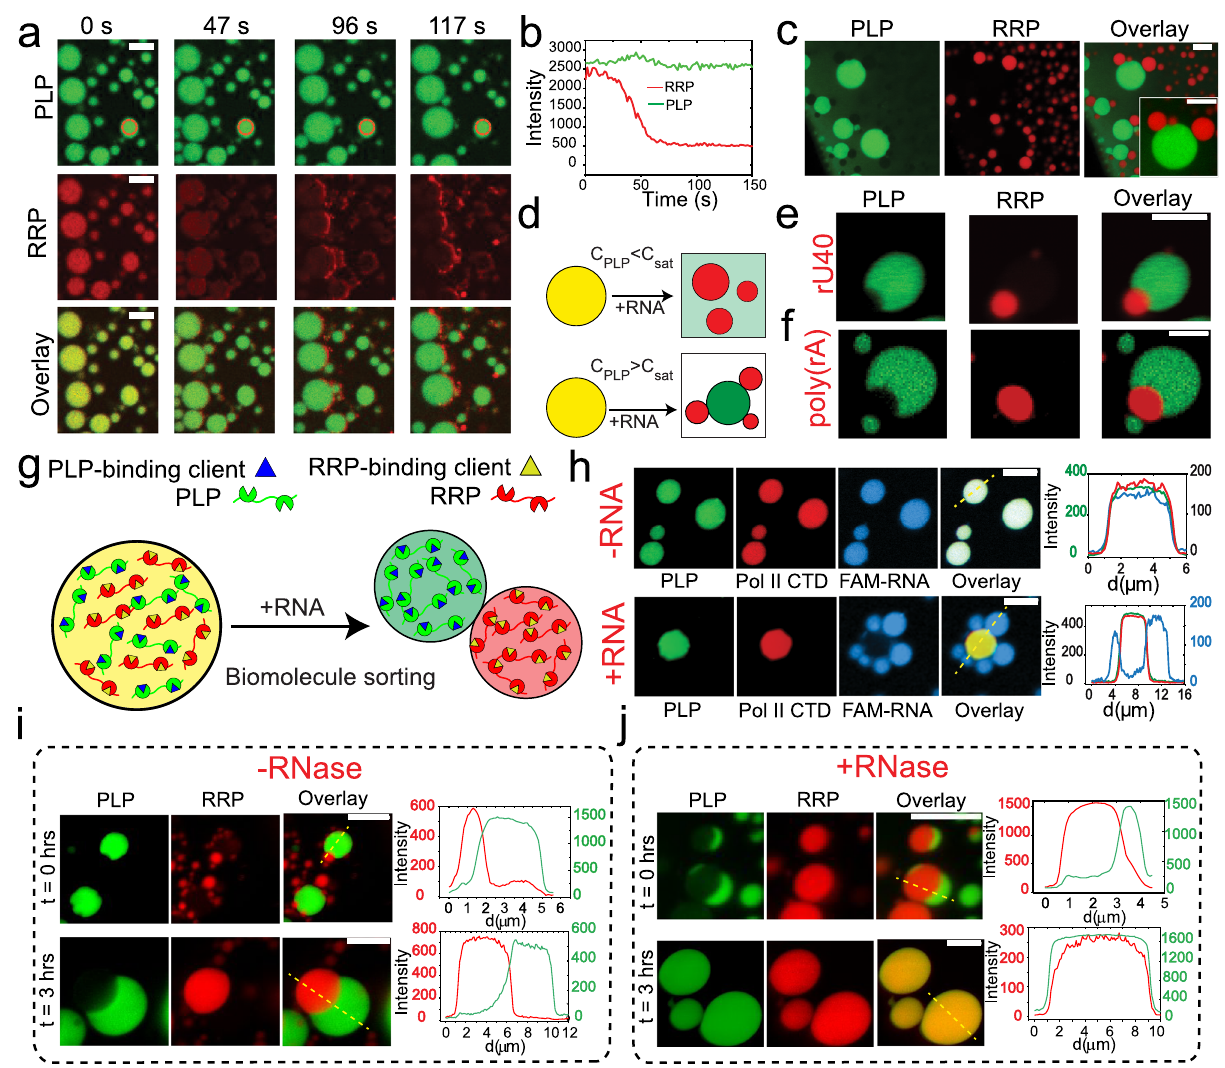
Fig. 3 RNA causes the demixing of RRP and PLP. a Fluorescence time-lapse images showing the sequestration of RRP (FUS RGG3 ) from PLP-RRP droplets and the formation of RRP-RNA droplets upon addition of poly(rU) RNA. [PLP] = 250 µ M; [FUS RGG3 ] = 750 µ M or 2.6mg/ml; and poly(rU) RNA is added to a fi nal concentration of 13mg/ml. b PLP and RRP intensities as a function of time within a PLP-RRP condensate [red circle in ( a )]. c Fluorescence images of coexisting PLP droplets and RRP-RNA droplets 20min after RNA addition. [PLP] = 250 µ M; [FUS RGG3 ] = 1250 µ M (4.3mg/ml); and poly(rU) RNA is added to a fi nal concentration of 10.8mg/ml. d A schematic diagram summarizing the effect of RNA on PLP-RRP condensates. e Fluorescence microscopy images of coexisting PLP condensates (green) and RRP-RNA condensates (red), prepared using rU40 RNA. Each type of droplet was prepared independently at initial concentrations of [PLP] = 400 µ M, [FUS RGG3 ] = 4.0mg/ml and [rU40] = 4.0mg/ml and then mixed (1:1 vol/vol). f Fluorescence images of the coexisting PLP condensates (green) and RRP-RNA condensates (red) prepared using poly(rA) RNA. g A schematic showing that RNA-induced de-mixing of PLP-RRP condensate (yellow) into PLP (green) and RRP-RNA (red) condensates can sort diverse clients into different condensates. h Fluorescence micrographs and intensity pro fi les showing recruitment of a FAM-labeled short ssRNA and Alexa488-labeled Pol II CTD into PLP-RRP condensates in the absence of RNA (top). These RNA and polypeptide molecules are differentially sorted when poly(rU) RNA is added to the mixture (bottom) − FAM-RNA (blue) into RRP-RNA condensates and Pol II CTD (red) into PLP condensates. PLP condensates (PLP = 400 µ M) were mixed (1:1 by volume) with a sample containing 4.0mg/ml [RGRGG] 5 and 0.0mg/ml (top) or 8.0 mg/ml (bottom) of poly(rU) RNA. i , j Fluorescence time-lapse images and intensity pro fi les (across the yellow dashed line) for coexisting PLP droplets and RRP-RNA ([RGRGG] 5 -rU40) droplets in the absence ( i ) and presence of RNase-A ( j ). Both samples were prepared at [PLP] = 400 μ M, [RGRGG] 5 = 1mg/ml and [rU40] = 1mg/ml. For the sample in (j), RNase-A concentration was 1.6mg/ml. Buffer contains 25mM Tris-HCl (pH = 7.5), 150mM NaCl, and 20mM DTT. PLP = FUS PLP . Scale bar = 10 µ m for ( a , c ) and 5 µ m for ( e – j